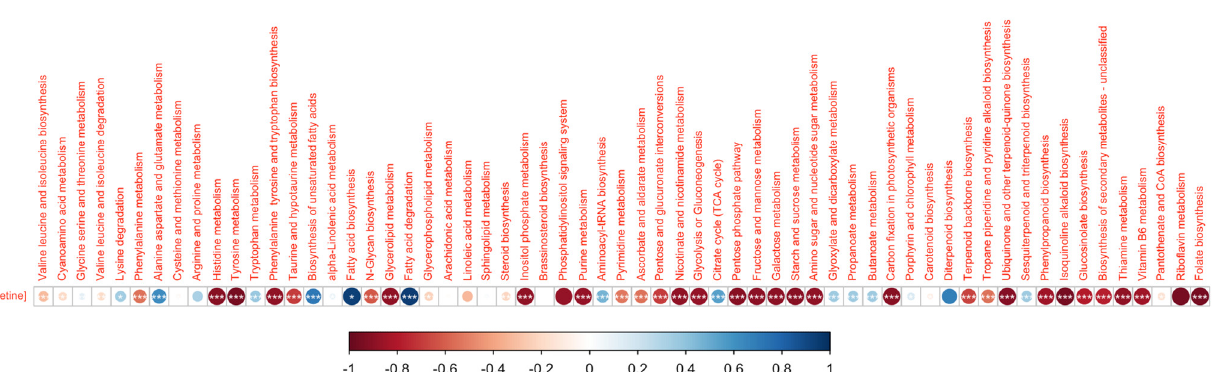
Figure 8. Fold-change of the selected potential biomarkers of fluoxetine exposure in the diatom cells exposed to 0.2, 20 and 80 µg/L fluoxetine ( n = 3, different letters denote significant differences at p < 0.05), database identification code (KEGG—Kyoto Encyclopaedia of Genes and Genomes; HMD—Human Metabolome Database; LM—LipidMaps), fluoxetine-fold-change correlation coefficient (R 2 ) and Variable Importance in Projection Partial Least-Squares Discriminant Analysis (VIP-PLS-DA) score.